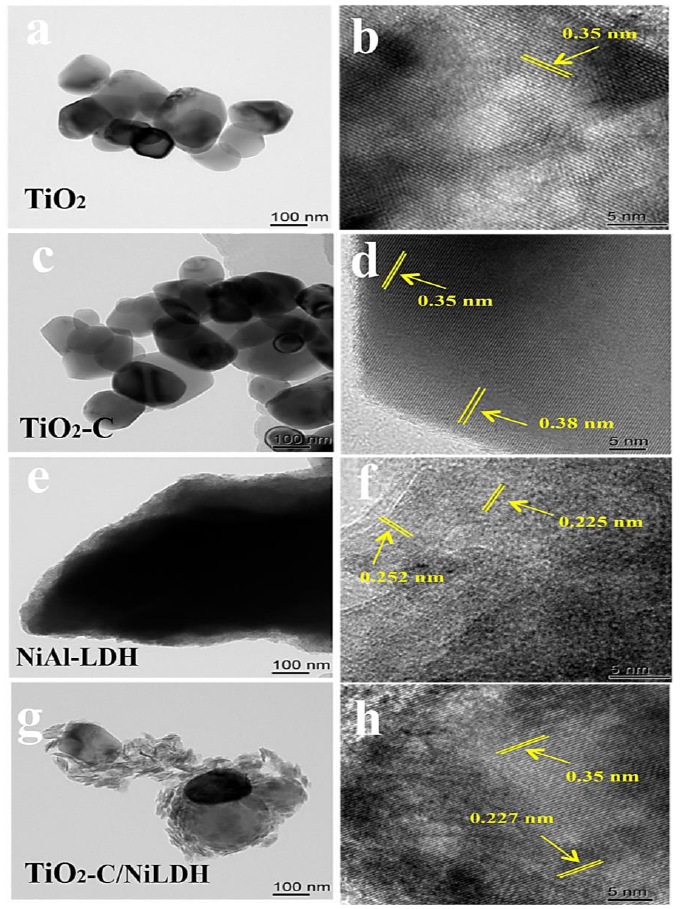
Figure 6. TEM and HRTEM images for TiO 2 ( a , b ), TiO 2 -C ( c , d ), NiAl-LDH ( e , f ) and TiO 2 -C/NiLDH amalgam ( g , h ). amalgam ( g , h